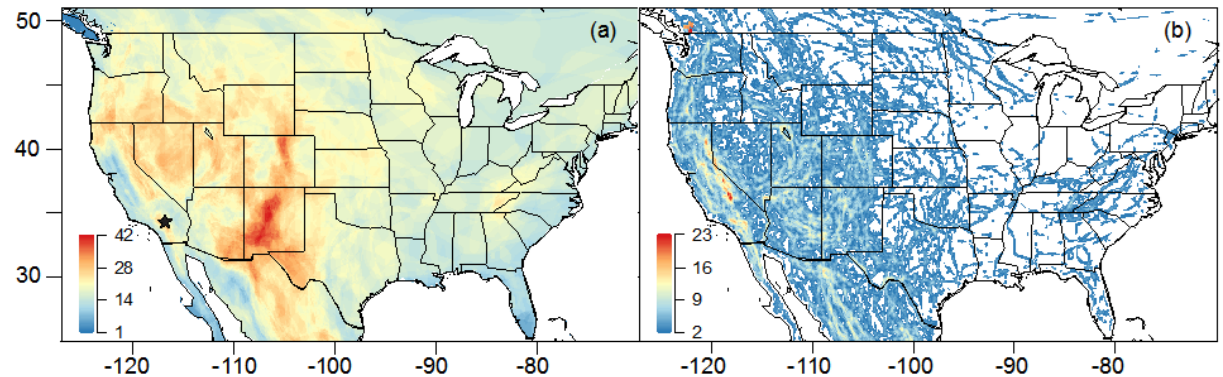
Figure 1. (a) Species richness of extant rodents and (b) distribution of overlapping range boundaries for two or more species, based on species’ ranges compiled at 0.1-degree resolution. Geographic-range data are from NatureServe (Patterson et al. 2007). Today, both species density and spatial turnover are greater in the region of recent tectonic activity and high topographic complexity. The star in (a) denotes the location of the primary fossil and paleoenviron- mental records investigated in this research. (Figure modified from Badgley et al. in